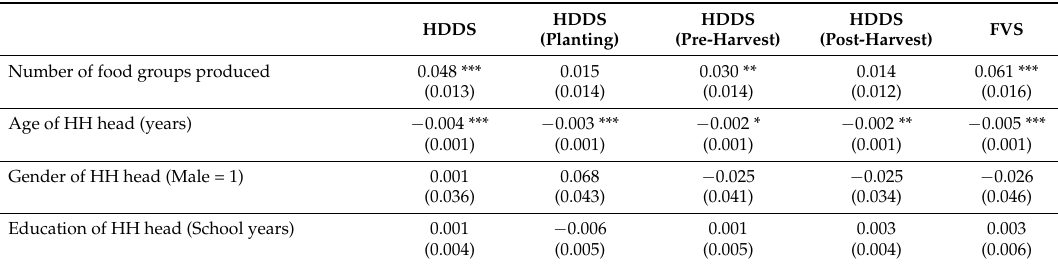
Table A2. Determinants of food consumption diversity in Chamwino (Production diversity indicator used: Number of food groups